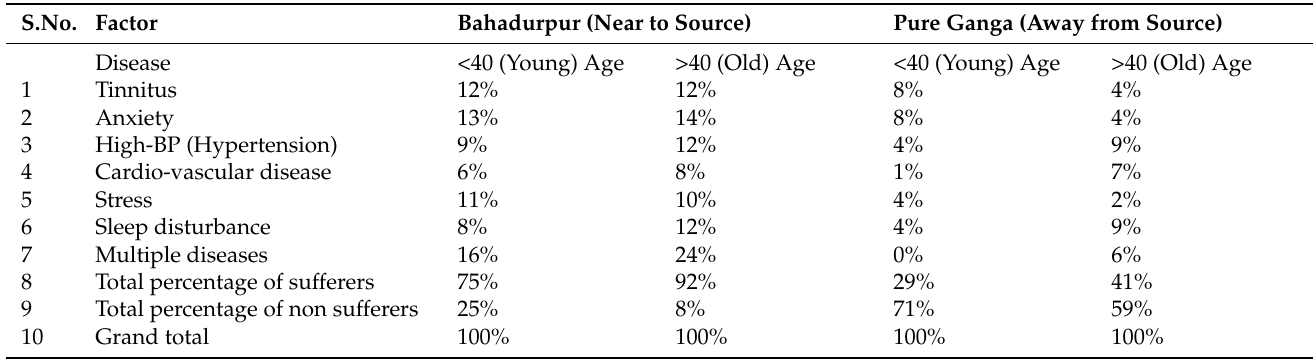
Table 2. Health hazard-based comparative analysis at Bahadurpur and Pure ganga.